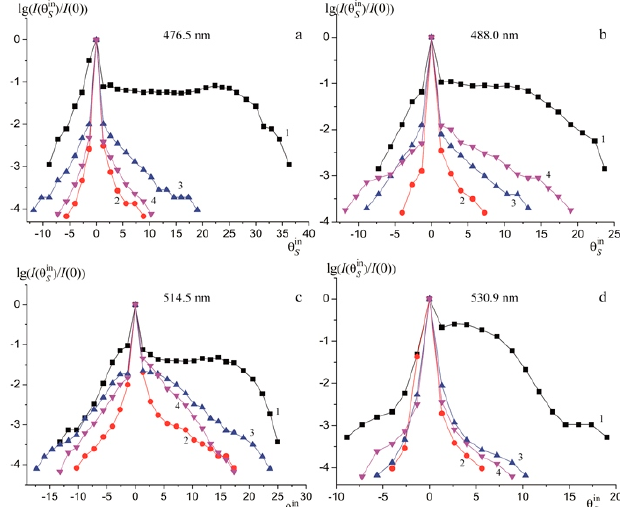
Figure 10. Angle distribution of scattered radiation intensity at excitation λ = 476.5 ( a ), 488.0 ( b ), 514.5 ( c ), 530.9 nm ( d ) for the crystals SLN (1), CLN (2) and LiNbO 3 :B (0.55 (3), 0.83 (4) mol%). The figure is reproduced with the permission of Pleiades Publishing from the paper N. V. Sidorov et al., Techn. Phys. 2020 V. 65 P. 627–634, DOI: https://doi.org/10.1134/S1063784220040192 (accessed on 26 March 2021).